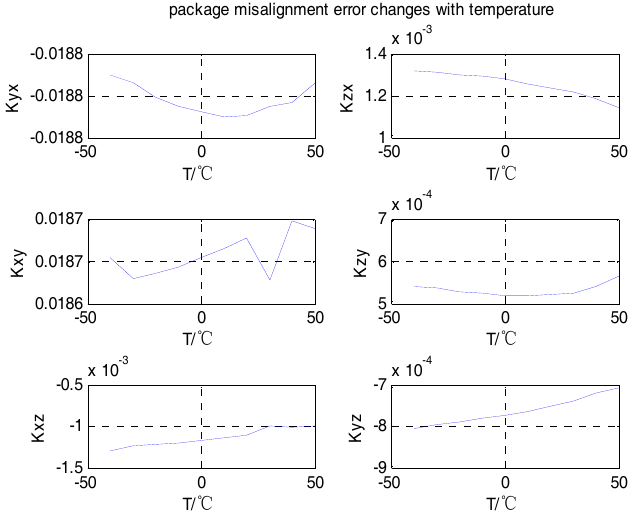
Figure 4. Scale factor varies with temperature.